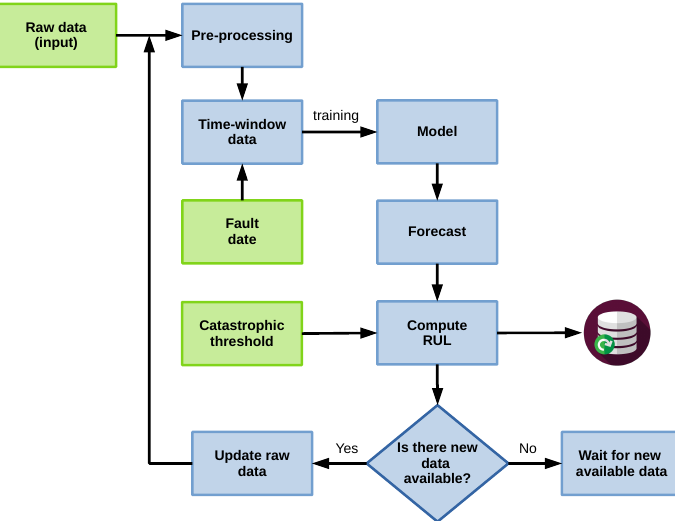
Figure 6. Prognostic process: strategy